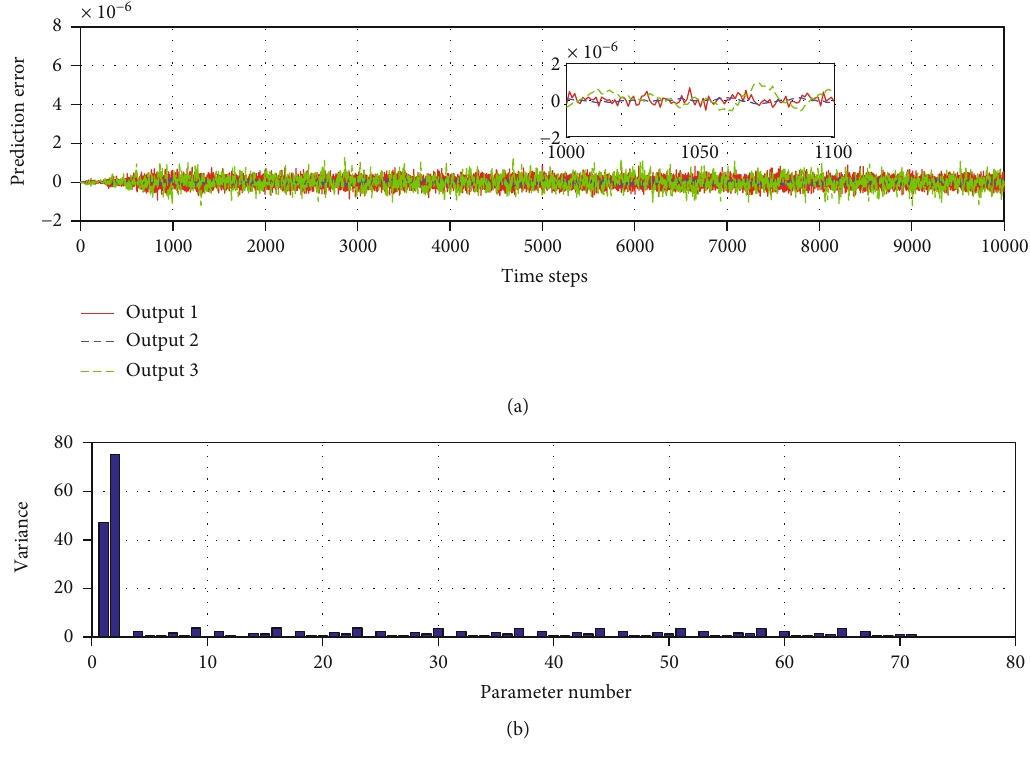
Figure 6: Prediction error for each step and computation variance of the OKID